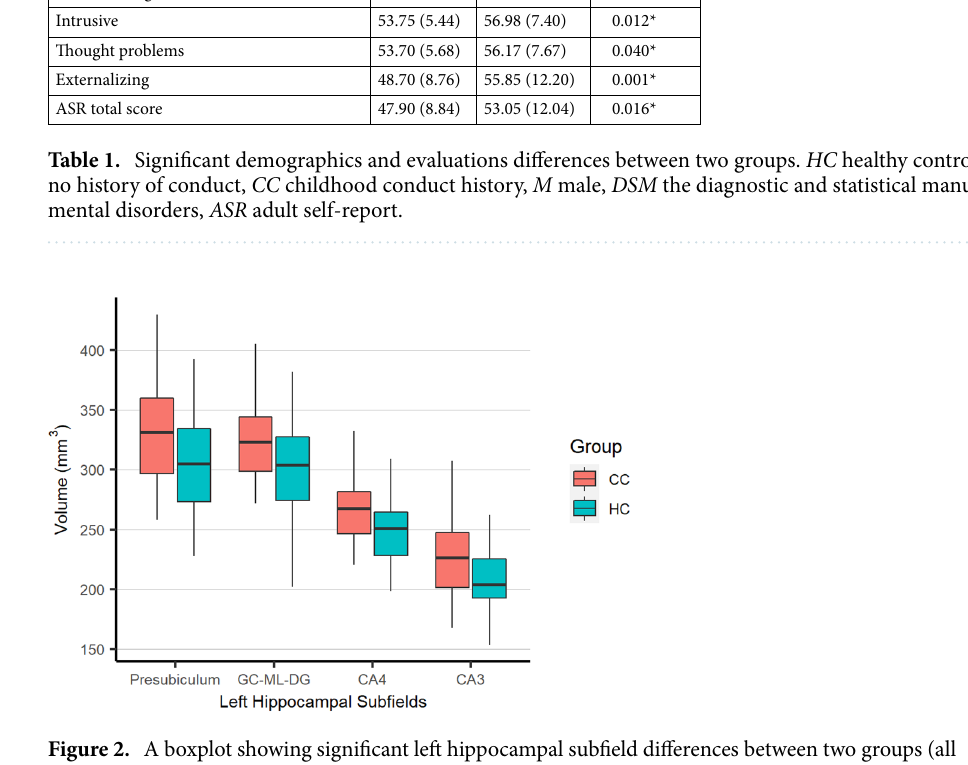
Figure 2. A boxplot showing significant left hippocampal subfield differences between two groups (all corrected p values < 0.05). CC: Childhood history of Conduct, HC: Healthy Controls, GC-ML-DG: Granule cell and molecular layer of dentate gyrus, CA: Cornu